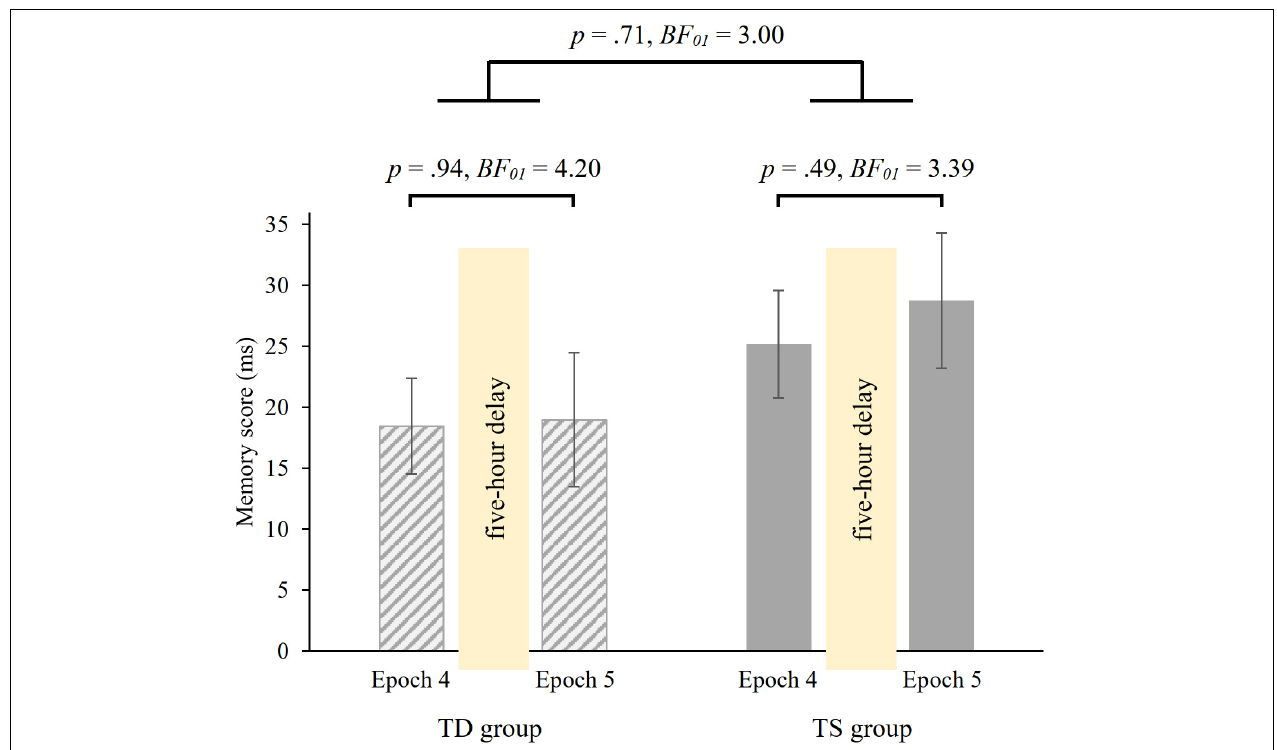
FIGURE 4 | 5-hour retention of knowledge of probability-based regularities in the TD and TS groups. Memory scores were measured by RT values for the last epoch of the Learning Phase (Epoch 4) and the first epoch of the Testing Phase (Epoch 5). Error bars denote the standard error of